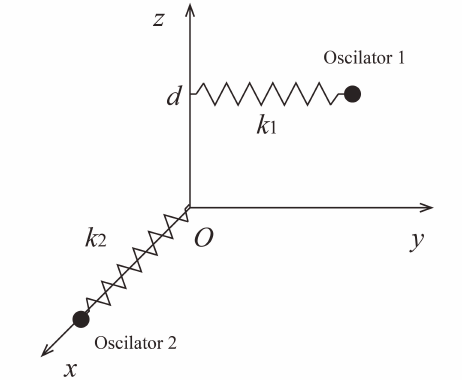
Figure 1. The two-coupled-oscillator model in optics of chiral